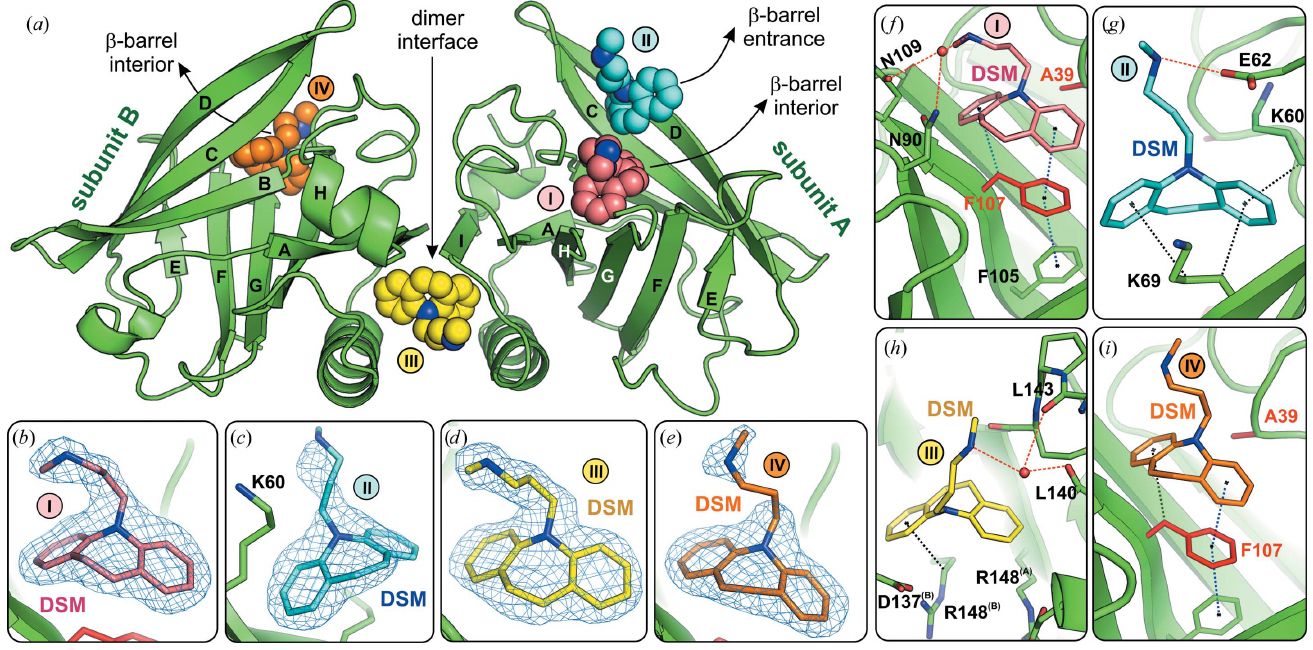
Figure 2 ( a ) Crystal structure of the FAF–DSM complex in cartoon representation with DSM molecules I, II, III and IV (space-filling representation) located at different binding sites ( (cid:2) -barrel interior, entrance and dimer interface). In subunit A , DSM I (pink) was bound in the (cid:2) -barrel interior, DSM II (cyan) was found at the (cid:2) -barrel entrance and DSM III (yellow) was located at the dimer interface. In subunit B , DSM IV (orange) was found in the (cid:2) -barrel interior. ( b )–( e ) 2 F o (cid:3) F c electron-density maps around ligand molecules I, II, III and IV contoured at the 1.0 (cid:6) level (difference omit maps are presented in Supplementary Fig. S1). ( f )–( i ) Interactions stabilizing the DSM molecules in their binding sites: hydrogen bonds (red dashed lines), hydrophobic contacts or C—H (cid:7)(cid:7)(cid:7) (cid:3) interactions (black dotted lines) and (cid:3) – (cid:3) stacking interactions (blue dotted lines). In ( h ), superscripts (A) or (B) mark residues belonging to chain A or B ,